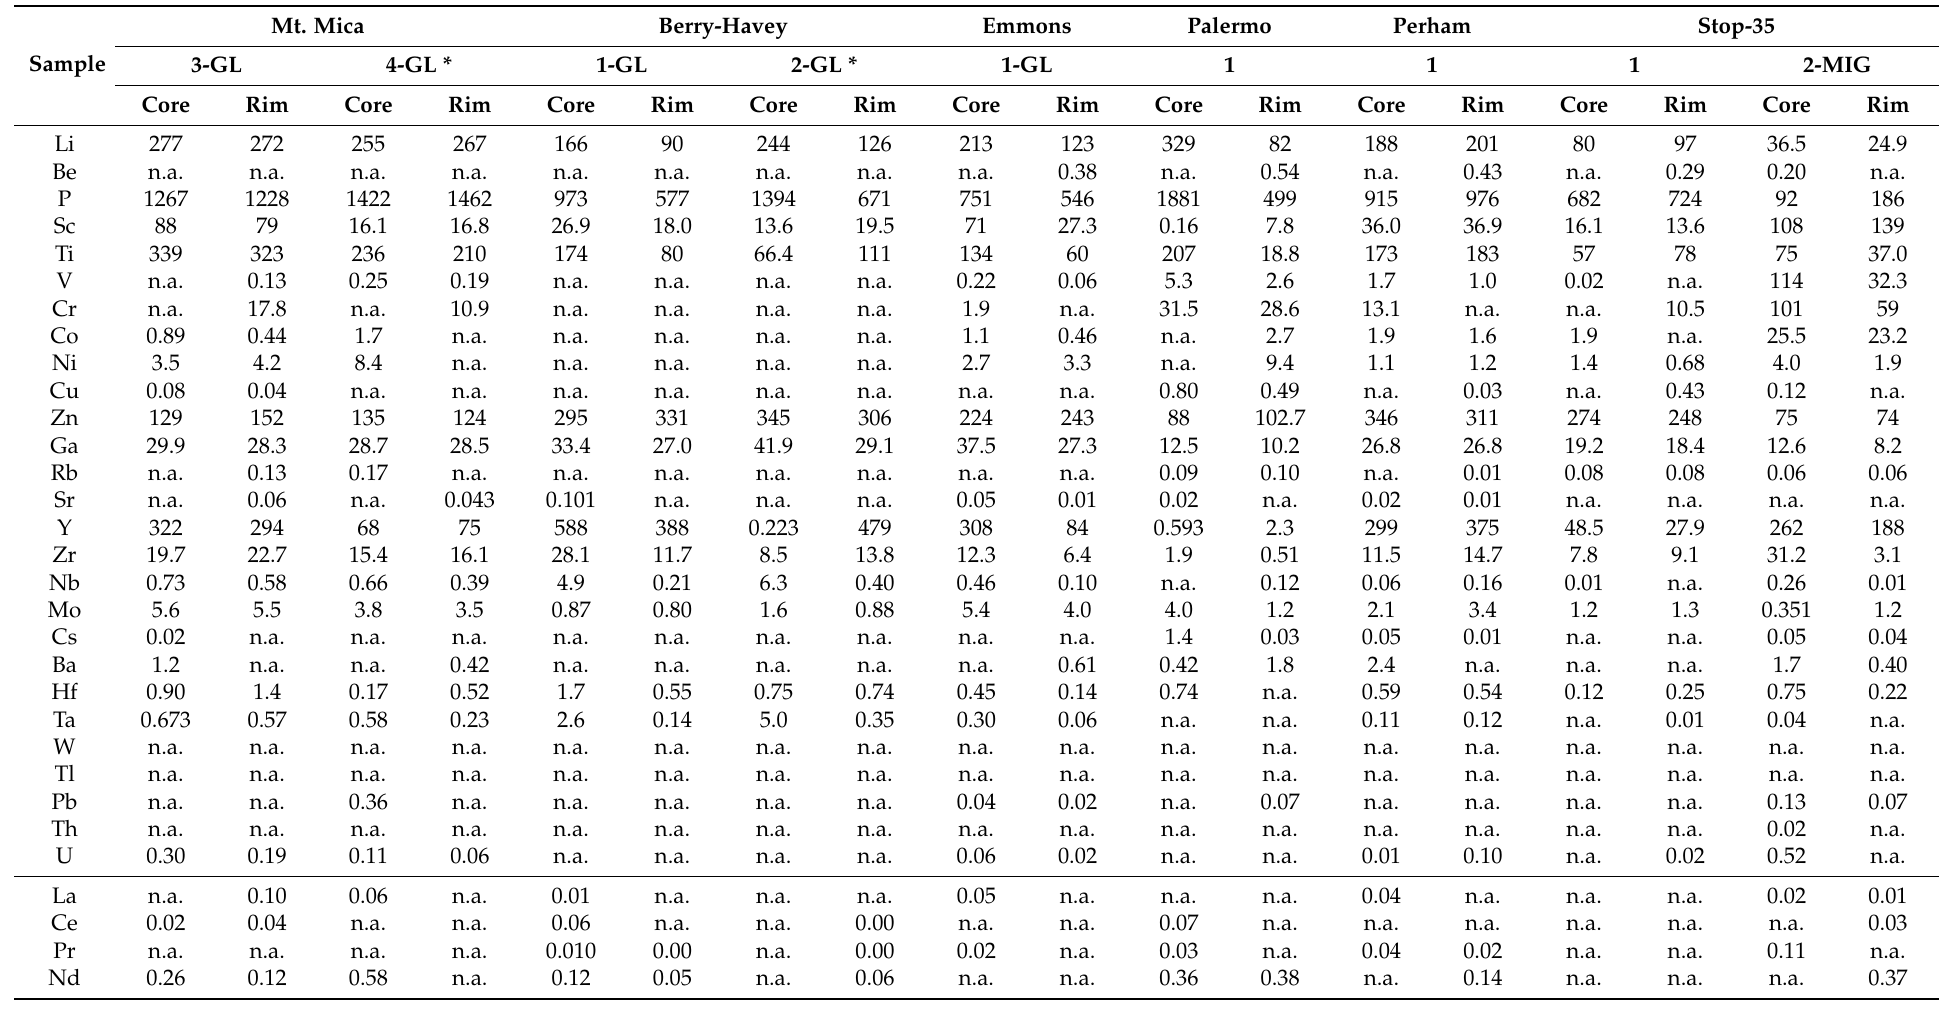
Table 2. Representative LA-ICP-MS analyses of garnets from the Oxford field pegmatites and migmatites and the Palermo No. 1 pegmatite. n.a. not analyzed. Values in ppm. Complete dataset available in Table S2 (Supplementary